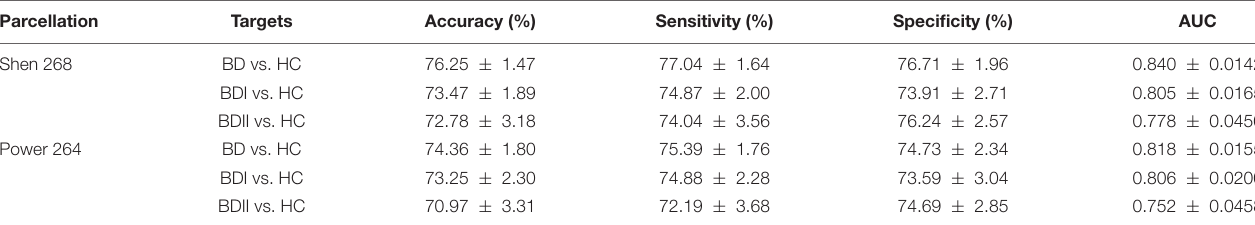
TABLE 2 | The classification performance of the testing